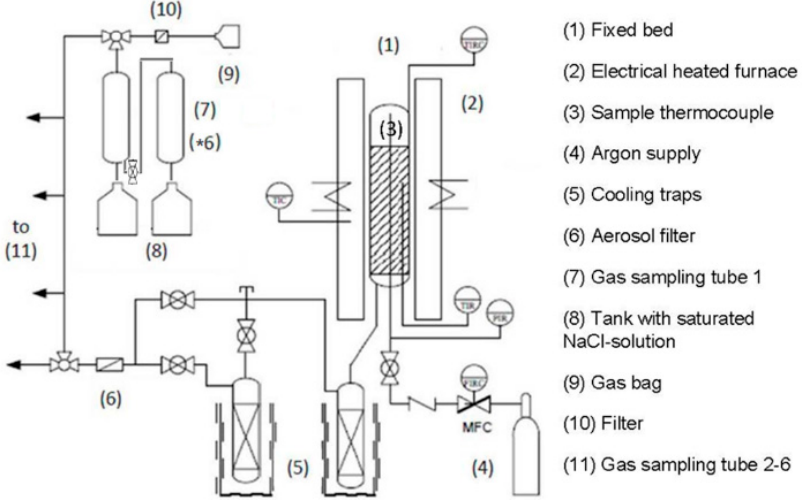
Figure 2. Schematic of fixed bed reactor (LPA).